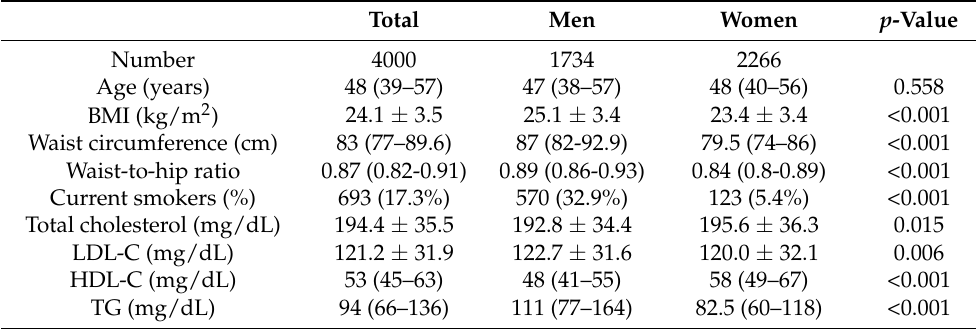
Table 1. Demographic characteristics of the Taiwan Biobank (TWB)